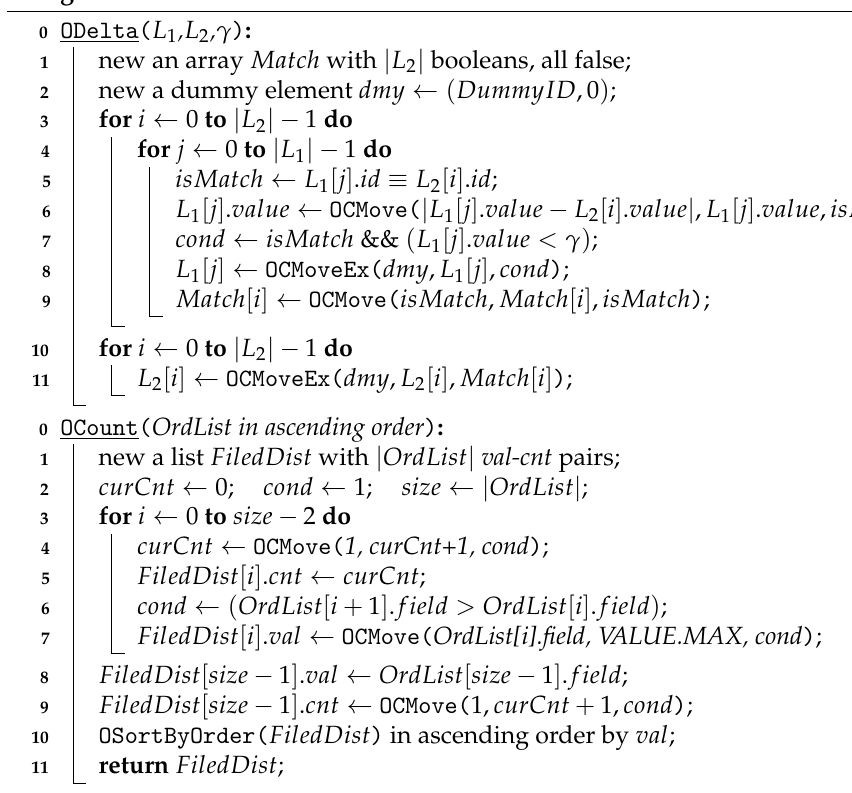
Algorithm 2: Oblivious delta and